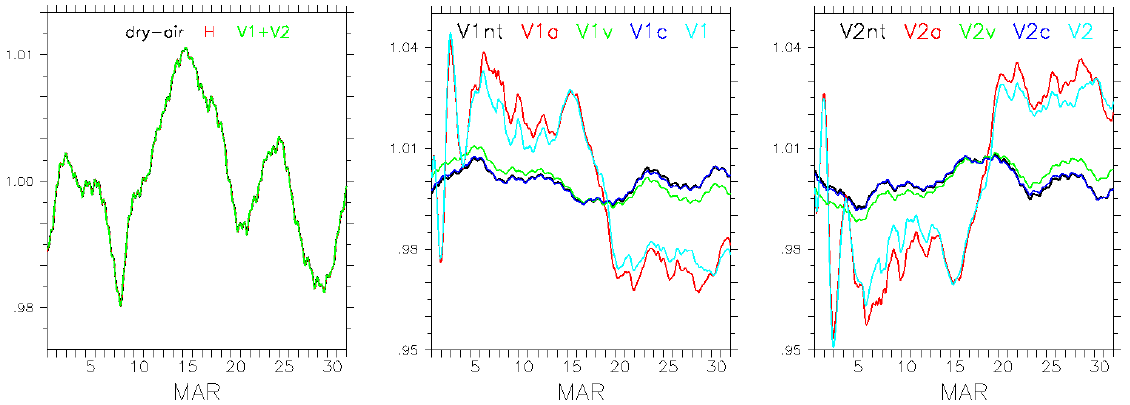
Fig. 6. Left: Integrated dry air and tracer masses normalised to their time averages (see text) for dry air, the homogeneous tracers H and V 1 + V 2 . The lines are on top of each other. Middle and right panel: Tracer masses normalised to their time average and divided by the mass of dry air normalised to its time average for the passive tracers V 1 (middle) and V 2 (right). All panels are for the COSMO- 7 simulation.